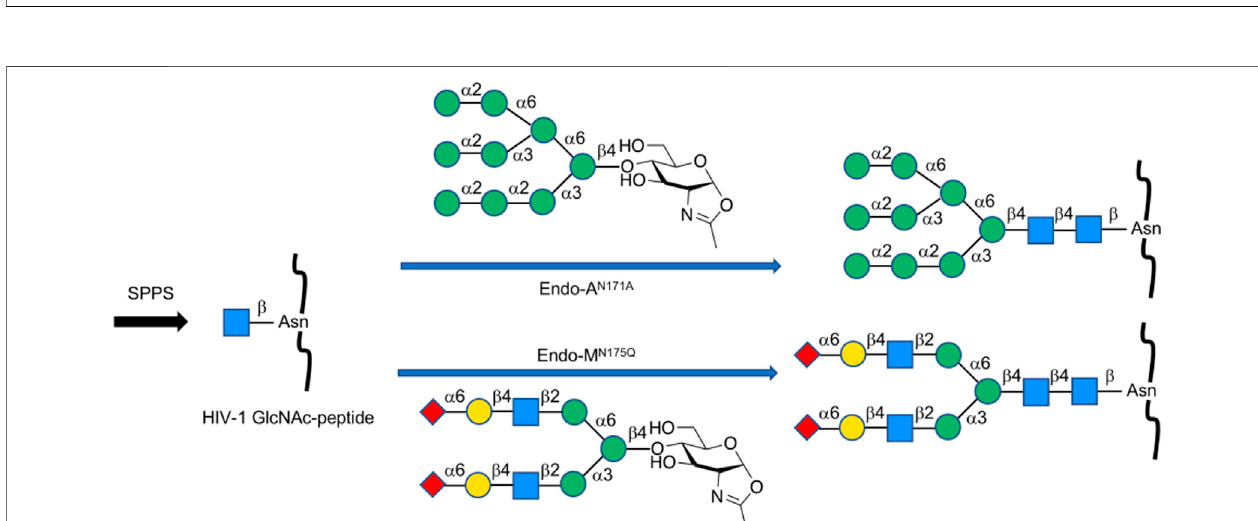
FIGURE 13 | Chemoenzymatic synthesis of homogeneous N -glycan-linked HIV-1 glycopeptides.